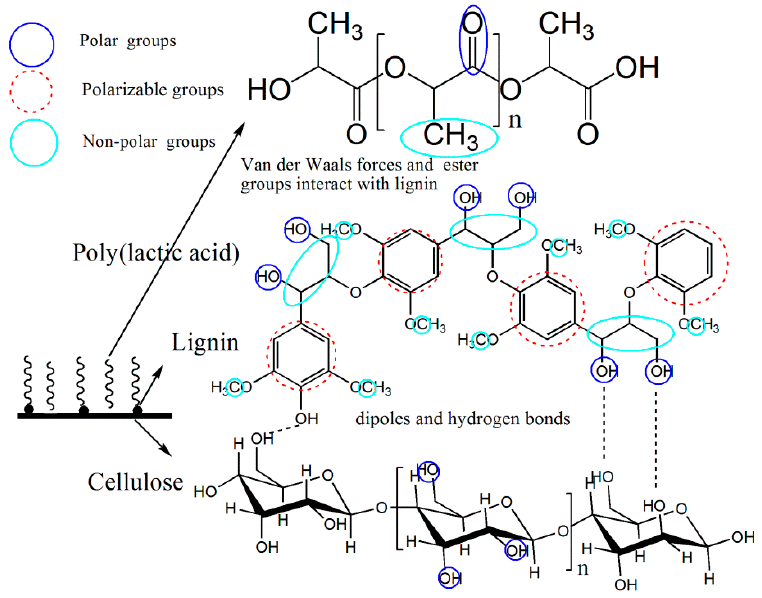
Figure 8. Reaction mechanism of PLA and LCNFs.